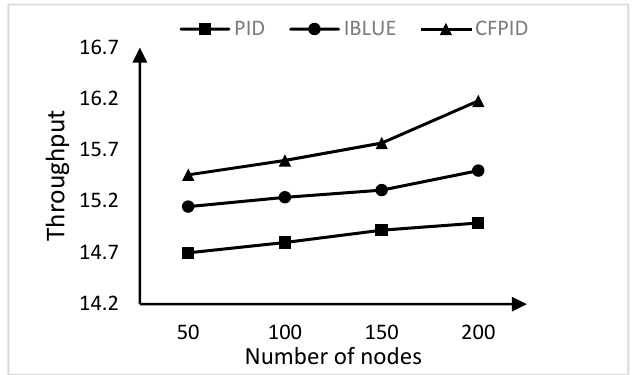
Figure 11. Throughput comparison.